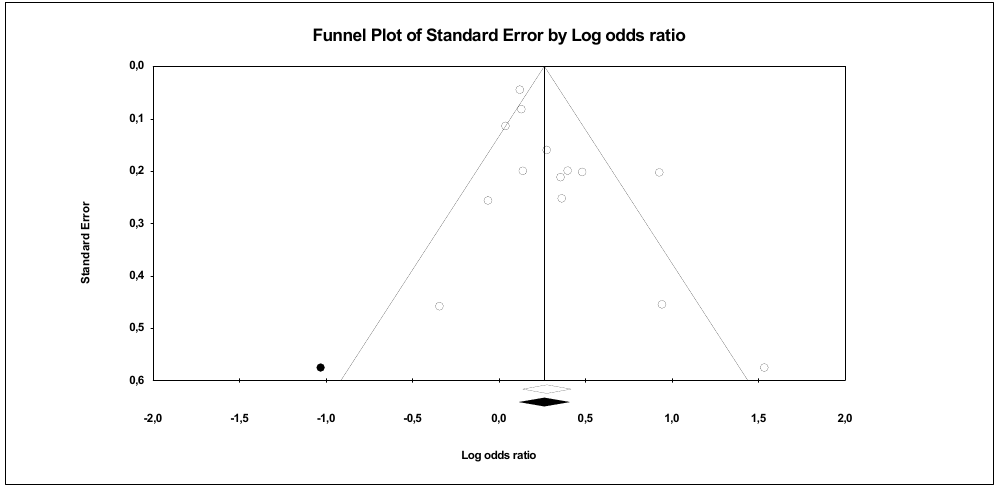
Figure 11. Funnel plots of observational studies of the association of PFOS exposure with CVDs and their risk factors. The publication bias is adjusted by imputing the missing studies based on the asymmetry of the funnel plot. (●) Plot Imputed and ( ○ ) Plot observed studies. Egger’s linear regression test (Intercept 1.33, t = 2.3, p = 0.04). Adjusted values ‘Trim and Fill’ test (1.30, CI = 1.12, 1.50).